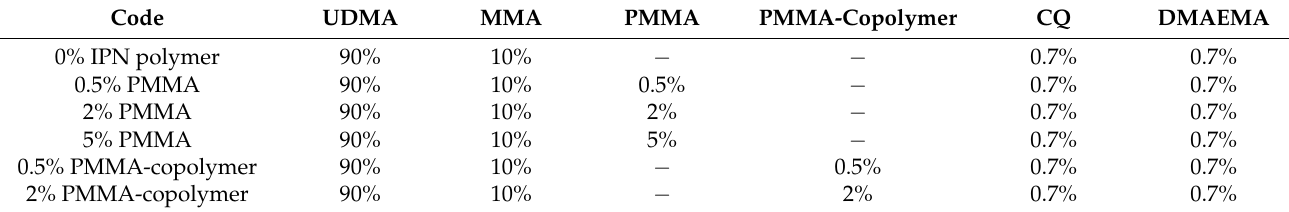
Table 2. Composition of IPN thermoplastic